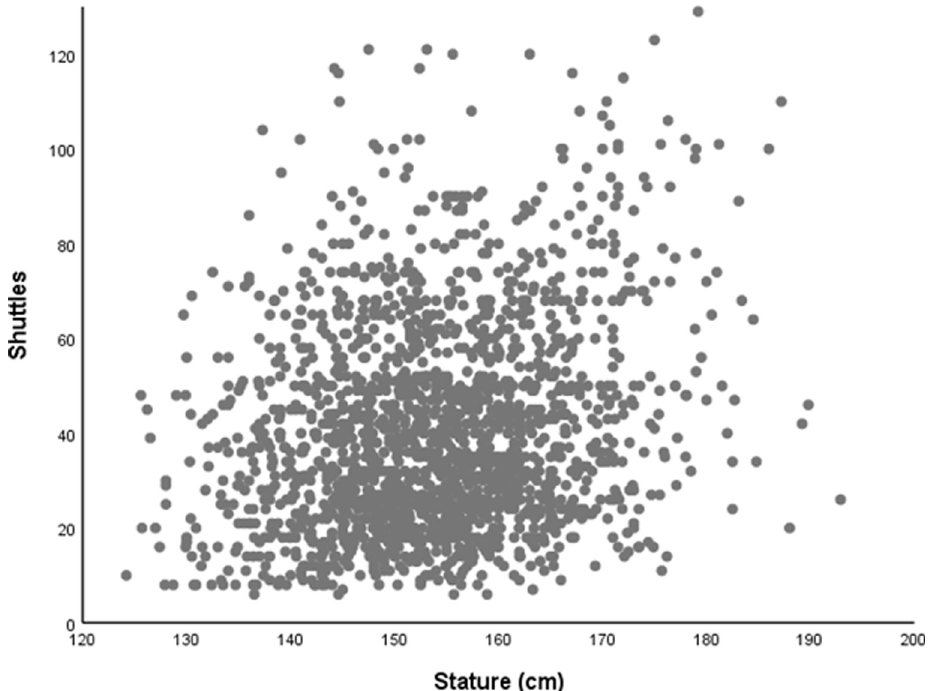
Fig 2. Association of 20 m shuttle-run performance with stature in English and Tanzanian schoolchildren (10.0– 15.9 years). Total shuttles shows as a continuous measure of performance on the 20 m shuttle-run test (FITNESSGRAM PACER protocol). Running-speed was derived from total shuttles. Stature (m) included as an index of overall body size.